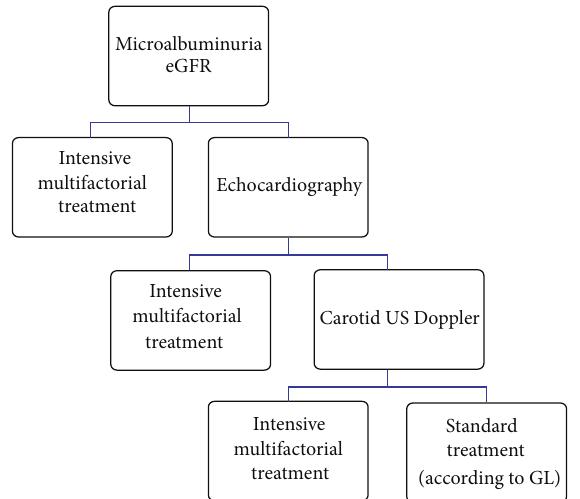
Figure 1: Looking for hypertensive target organ damage in clinical practice: the role of the kidney. Proposed diagnostic and therapeutic algorithm for the management of hypertension. A rational, cost- effective search for organ damage must start from low-cost, easy-to- perform tests and proceed to more expensive ones only in patients resulting at relatively low overall risk on the basis of previous risk stratification (modified from